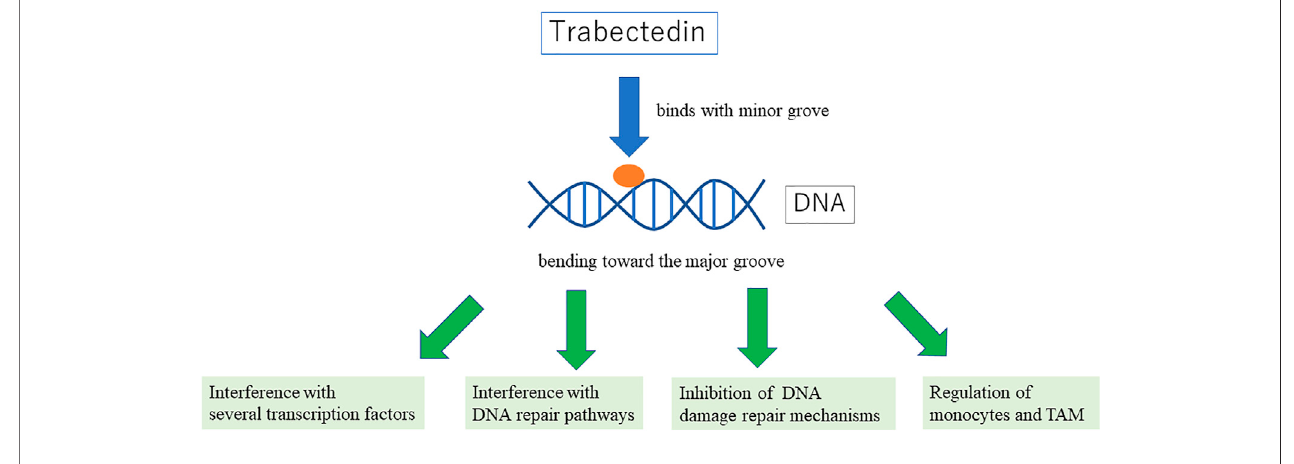
FIGURE 1 | showing the mechanism of